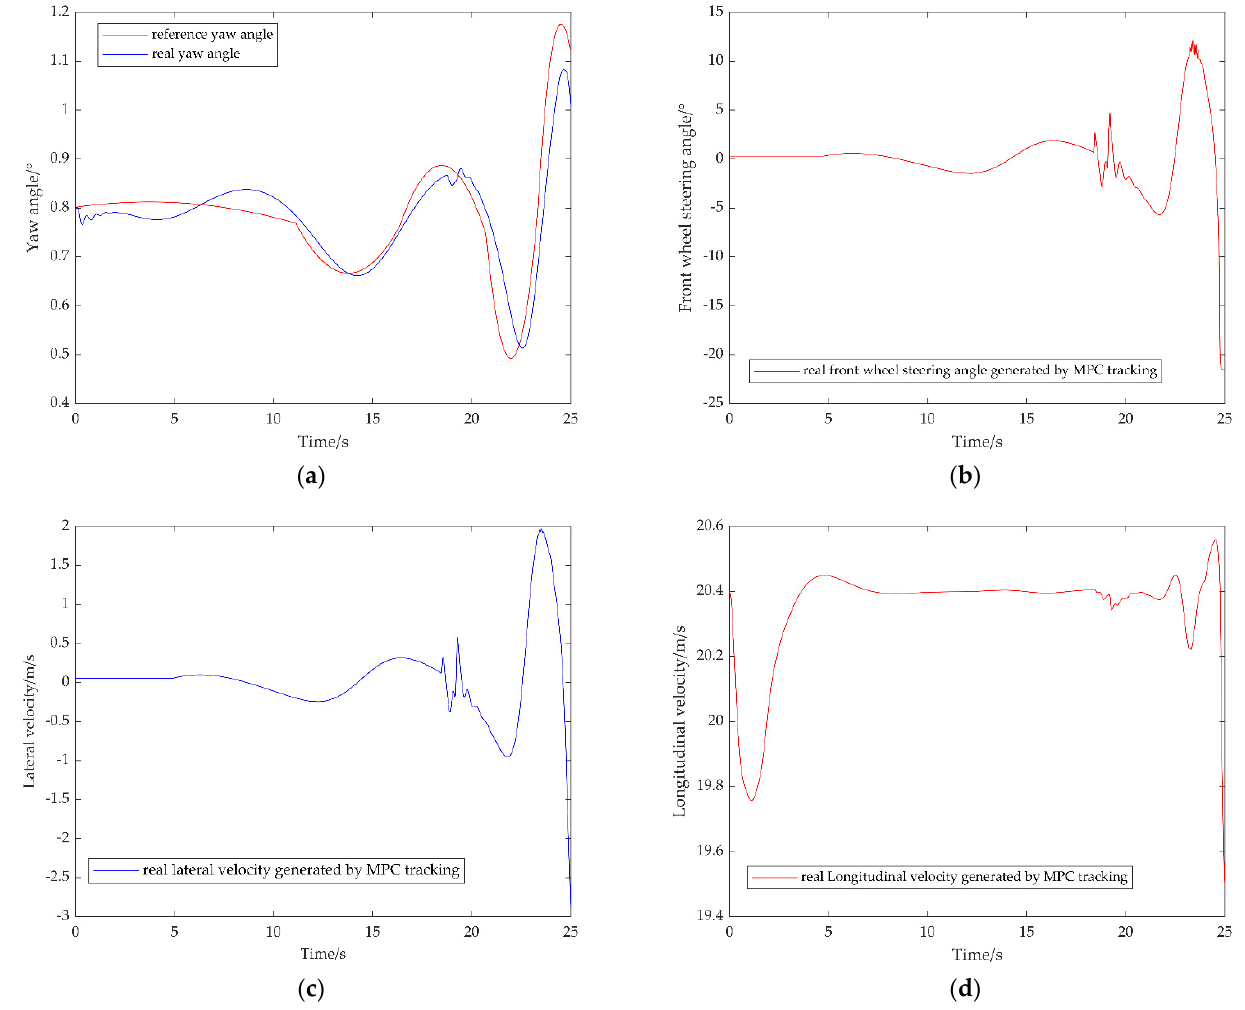
Figure 4. ( a ) Comparison of reference yaw angle and real yaw angle; ( b ) generated front wheel steering angle; ( c ) generated lateral velocity; ( d ) generated longitudinal velocity. steering angle; ( c ) generated lateral velocity; ( d ) generated longitudinal